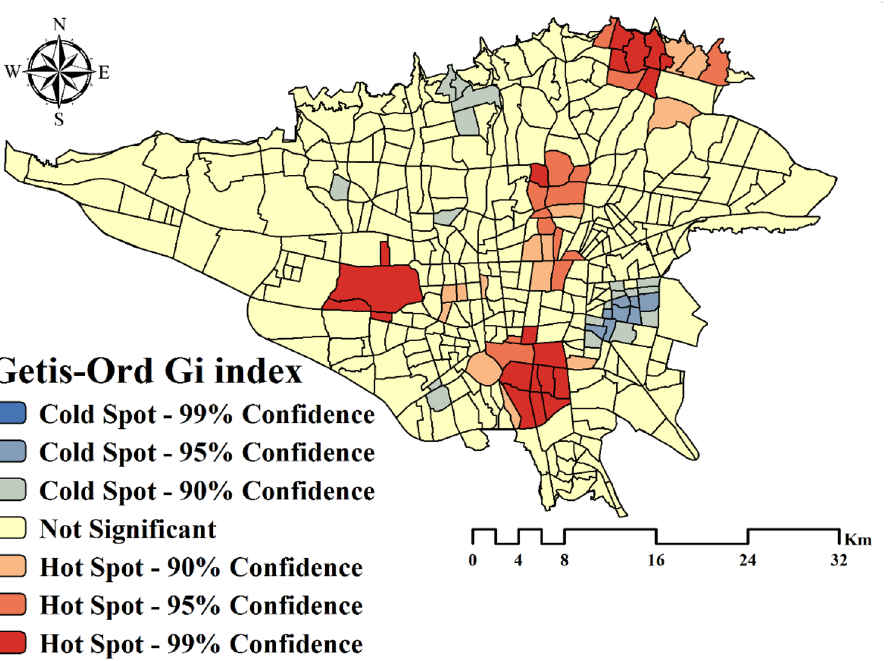
Figure 4. Spatial clusters using Getis-Ord Gi* index. This map was generated using the tool of ArcGIS 10.3 (ESRI, Redlands, CA, USA,